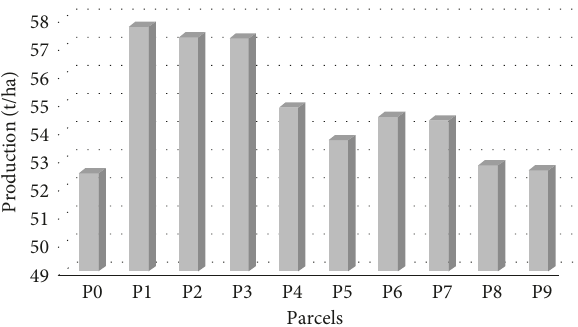
Figure 7: Production yield of harvested